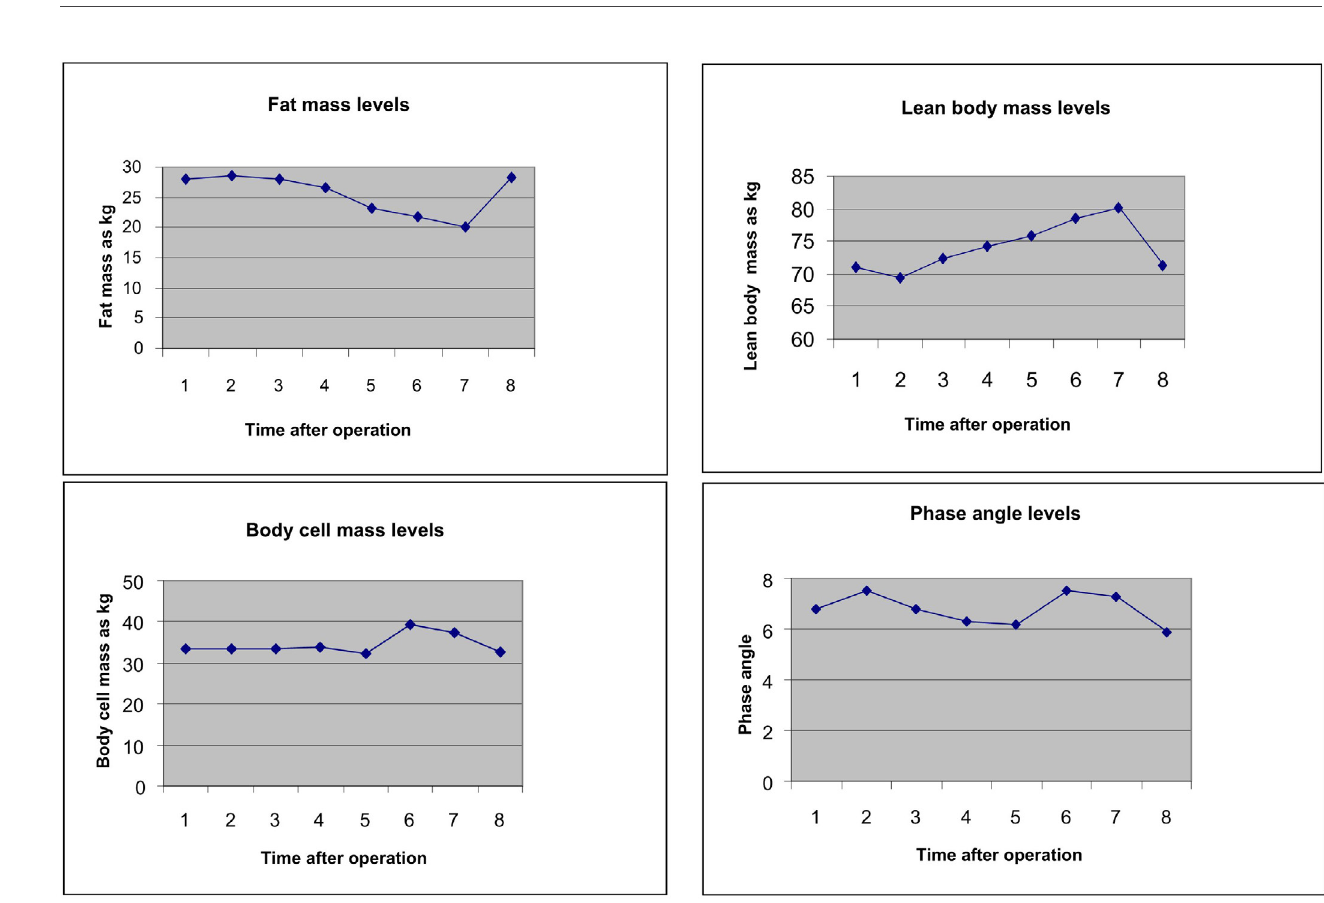
Fig. 2 – Changes in fat mass, lean body mass, body cell mass, and phase angle levels after cardiopulmonary